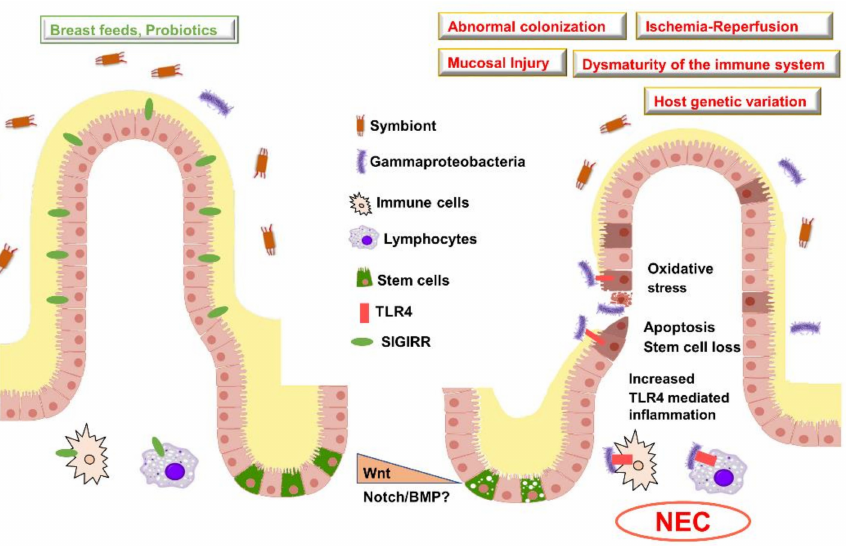
Figure 1. Risk factors and pathogenesis of NEC. Illustration of a healthy villus ( left ) versus villus injured in NEC ( right ). In preterm neonates who do not develop NEC, there is an intact mucin barrier, gut colonization with symbionts, less pro-inflammatory signaling, and increased expression in anti-inflammatory genes such as Single Immunoglobulin Interleukin-1 Related Receptor (SIGIRR). In infants who develop NEC, there is aberrant activation of Toll Like Receptor in association with increased Gammaproteobacteria , pro-inflammatory signaling, and bacterial translocation accompanied with reduced mucin barrier. Early studies suggest that, in NEC, Wnt signaling may be reduced accompanied with the loss of intestinal stem cells. Wnt, Wingless related integration site; BMP, Bone morphogenetic protein; TLR, Toll-like receptor; NEC, Necrotizing